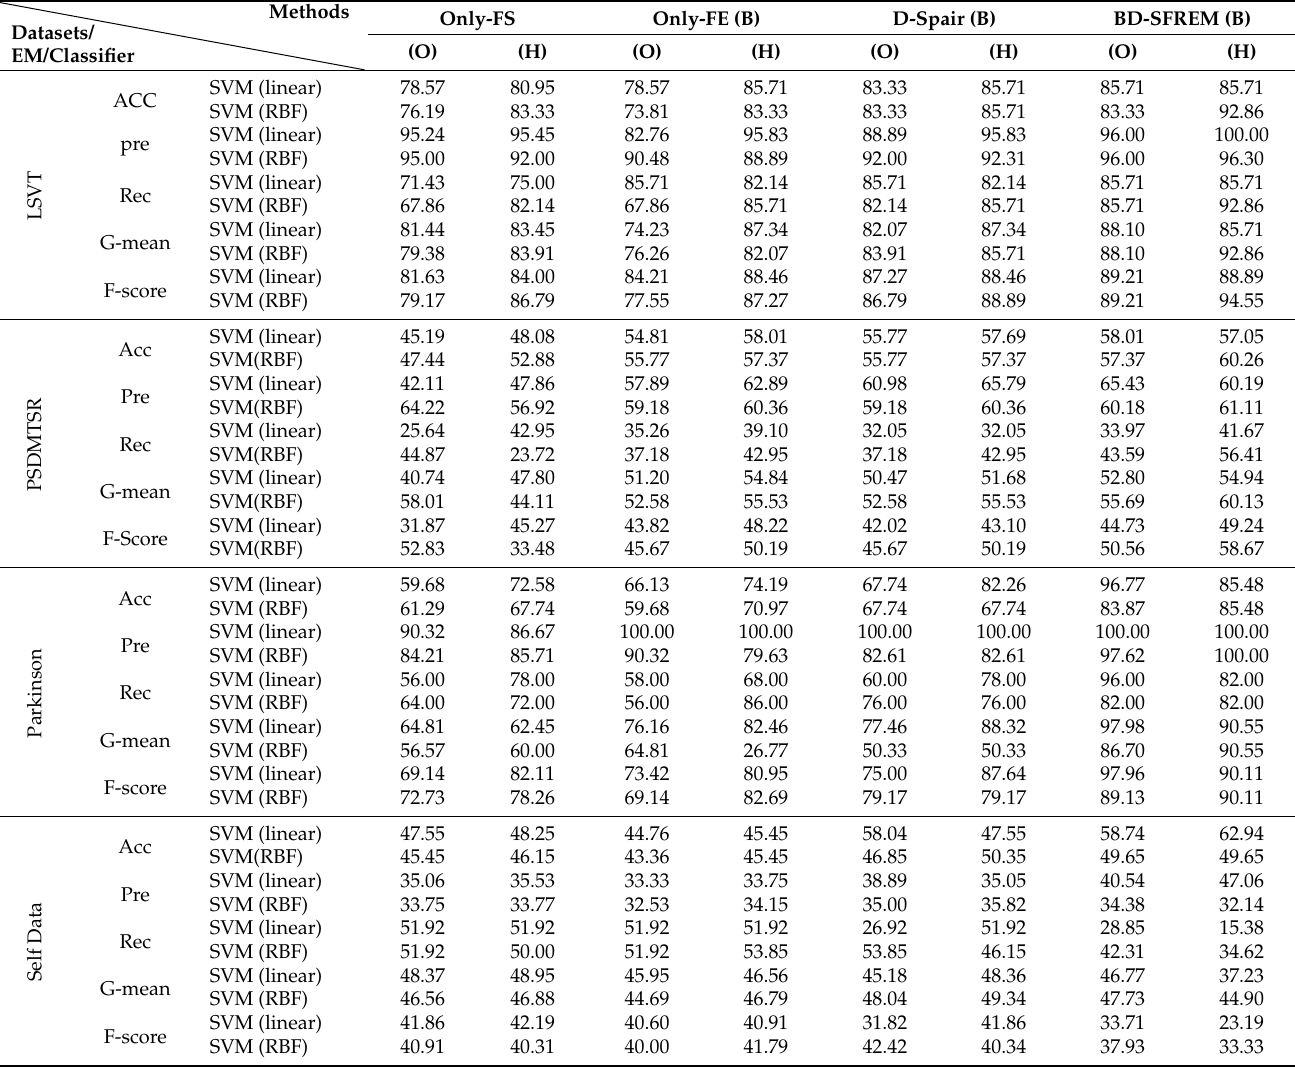
Table 5. Verification of hierarchy space instance learning mechanism